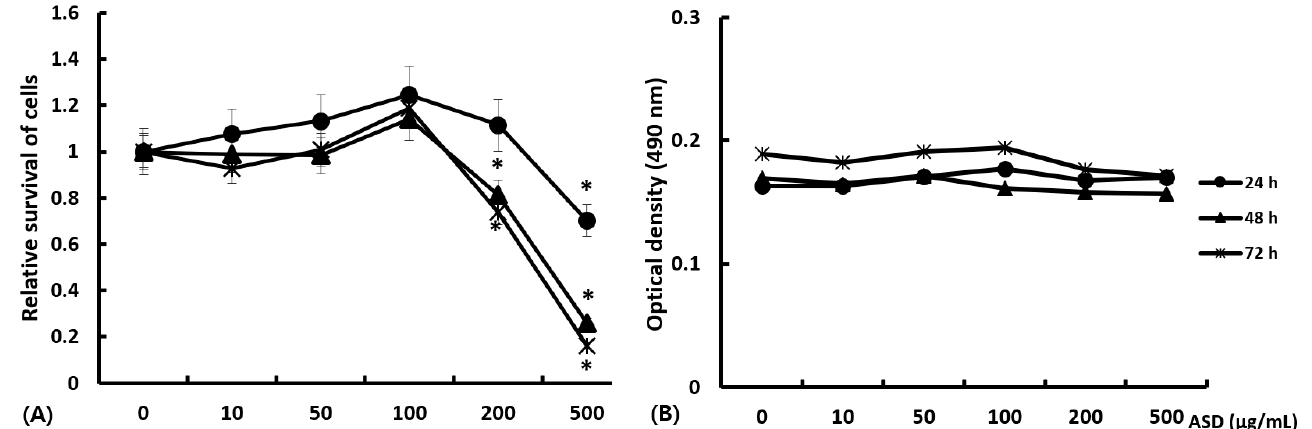
Figure 1. Cell viability effect of Asian sand dust (ASD) on primary nasal epithelial cells. ( A ) shows relative survival of nasal epithelial cells treated with 0 to 500 μ g/mL of ASD for 72 h. Cell survival was significantly decreased above ASD concentrations of 200 μ g/mL. Stimulation time did not influence the survival of nasal epithelial cells. ( B ) shows absolute optical density of different ASD concentrations without cells. *: p < 0.05 compared to without ASD, k = 10.